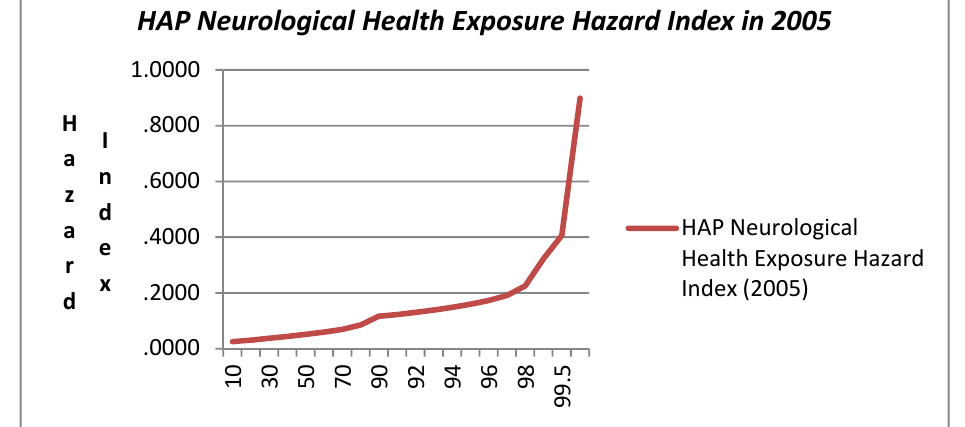
Figure 4. Hazardous Air Pollution (HAP) Neurological Health Exposure Hazard Index (2005) Values at Selected Percentiles for U.S. Census Tracts (U.S. E.P.A. National Air Toxics Assessment, 2005)